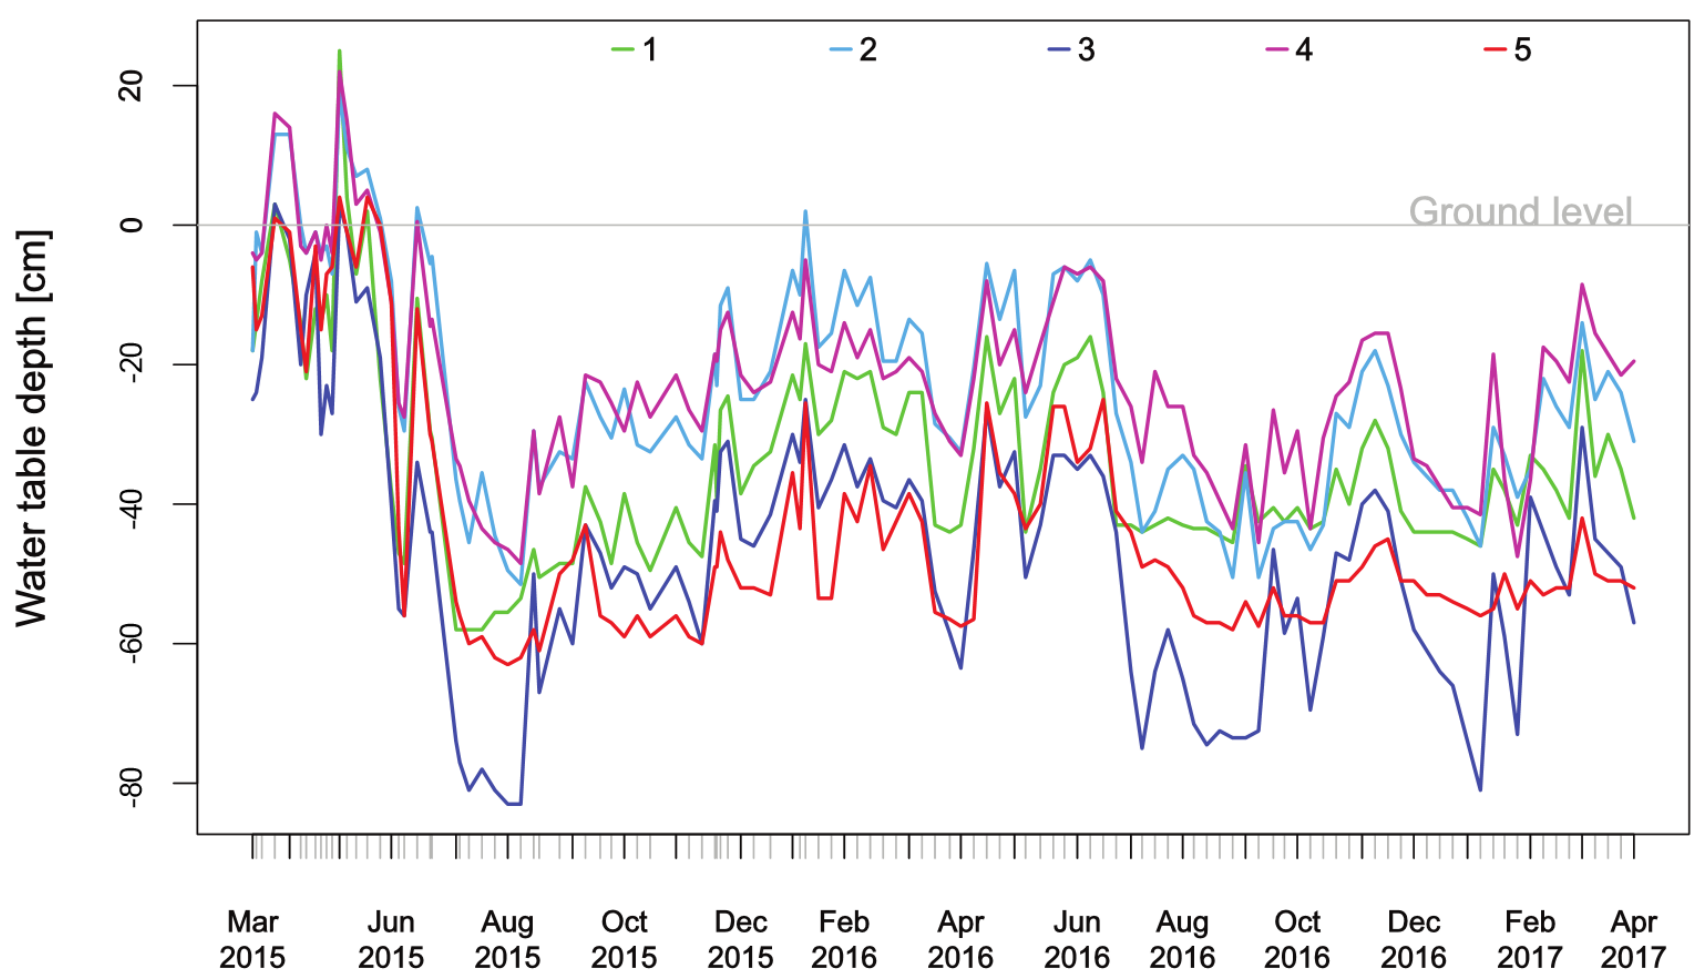
Figure A2. Fluctuation of water table depth measured in five dipwells in the experimental peatland at Neuchâtel Botanic Garden between March 2015 and April 2017. The horizontal line represents ground level ( i.e . peat surface or top of moss carpet). The peatland was very wet during the spring of 2015, then the water table dropped sharply during the summer drought of 2015. The water level recovered during winter and the spring of 2016, but then dropped again in the summer of 2016 and did not recover